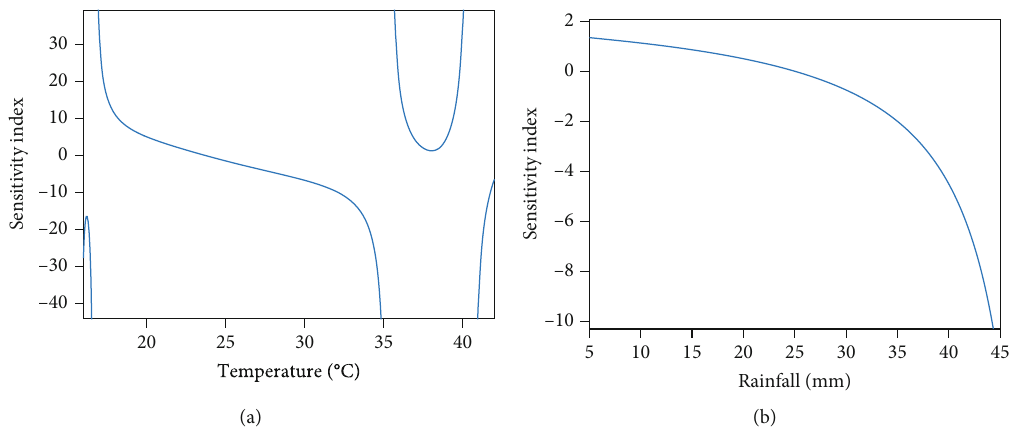
Figure 1: (a) Sensitivity indices of the basic reproduction number with respect to temperature. (b) Sensitivity indices of the basic reproduction number with respect to